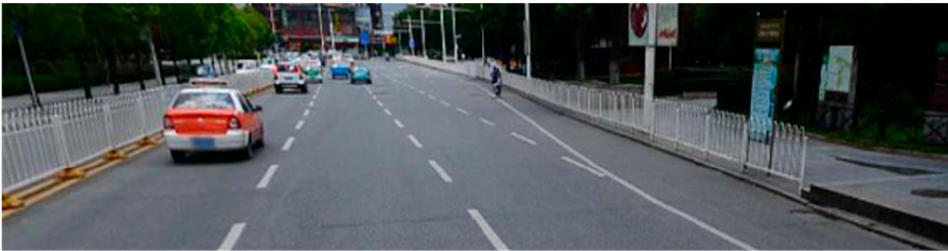
Figure 9. Different division strategies corresponding to the number of lanes.